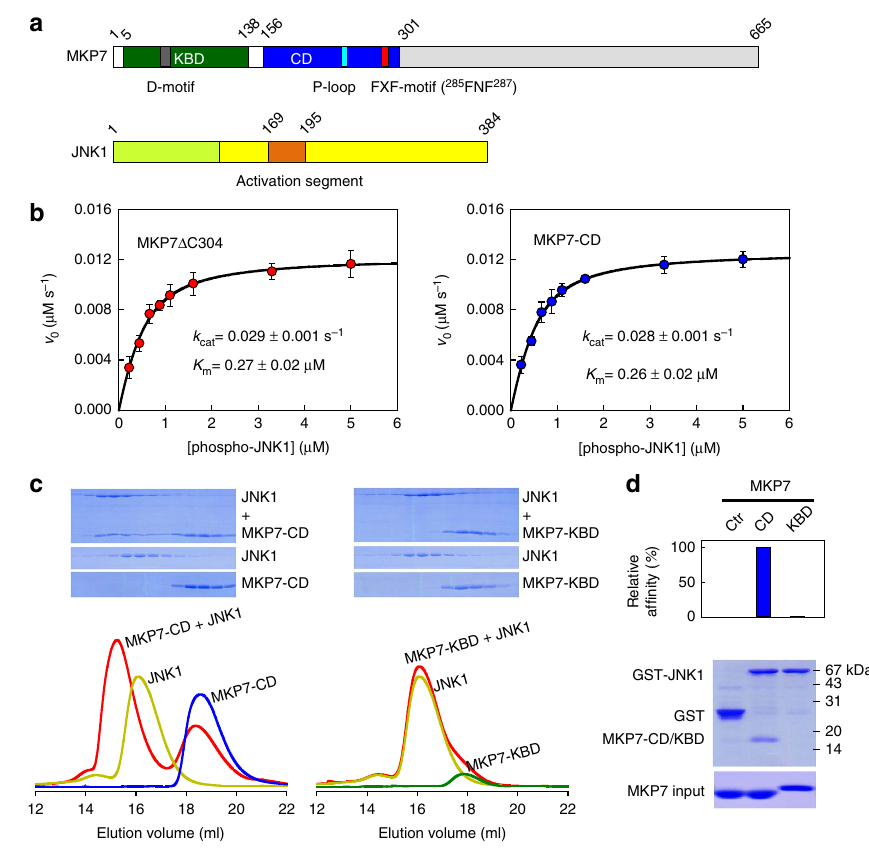
Figure 2 | MKP7-CD is crucial for JNK1 binding and enzyme catalysis. ( a ) Domain organization of human MKP7 and JNK1. The KBD and CD of MKP7 are shown in green and blue, and the N-lobe and C-lobe of JNK1 are coloured in lemon and yellow, respectively. The key structural elements are indicated. The colour scheme is the same in the following figures unless indicated otherwise. ( b ) Plots of initial velocity of the MKP7-catalysed reaction versus phospho- JNK1 concentration. The solid lines are best-fitting results according to equation (1). Each experiment was performed in replicate for at least three times. The error bars represent s.e.m. ( c ) Gel filtration analysis for interaction of JNK1 with MKP7-CD and MKP7-KBD. ( d ) GST-mediated pull-down assay for interaction of JNK1 with MKP7-CD and MKP7-KBD. The top panel shows the relative affinities of MKP7-CD and MKP7-KBD to JNK1, with the affinity of MKP7-CD defined as 100%; the middle panel is the electrophoretic pattern of MKP7 and JNK1 after GSTpull-down assays. The protein amounts of MKP7 used are shown at the bottom.